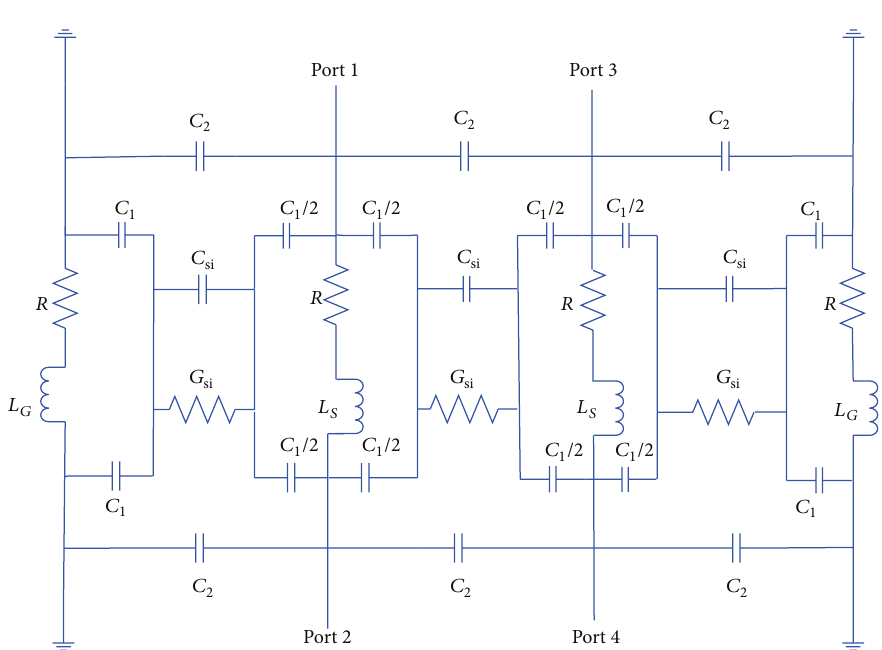
Figure 4: Electrical model of the proposed TSV structure. ( 𝐶 1 = 𝐶 TSV + 𝐶 BUMP , 𝐶 2 = 𝐶 underfill + 𝐶 OX , 𝑅 = 𝑅 TSV + 2 × 𝑅 BUMP , 𝐿 𝑆 = + 2 × 𝐿 𝐿 = 𝐿 + 2 × 𝐿 𝐿 TSVS BUMPS , and 𝐺 TSVG BUMPG